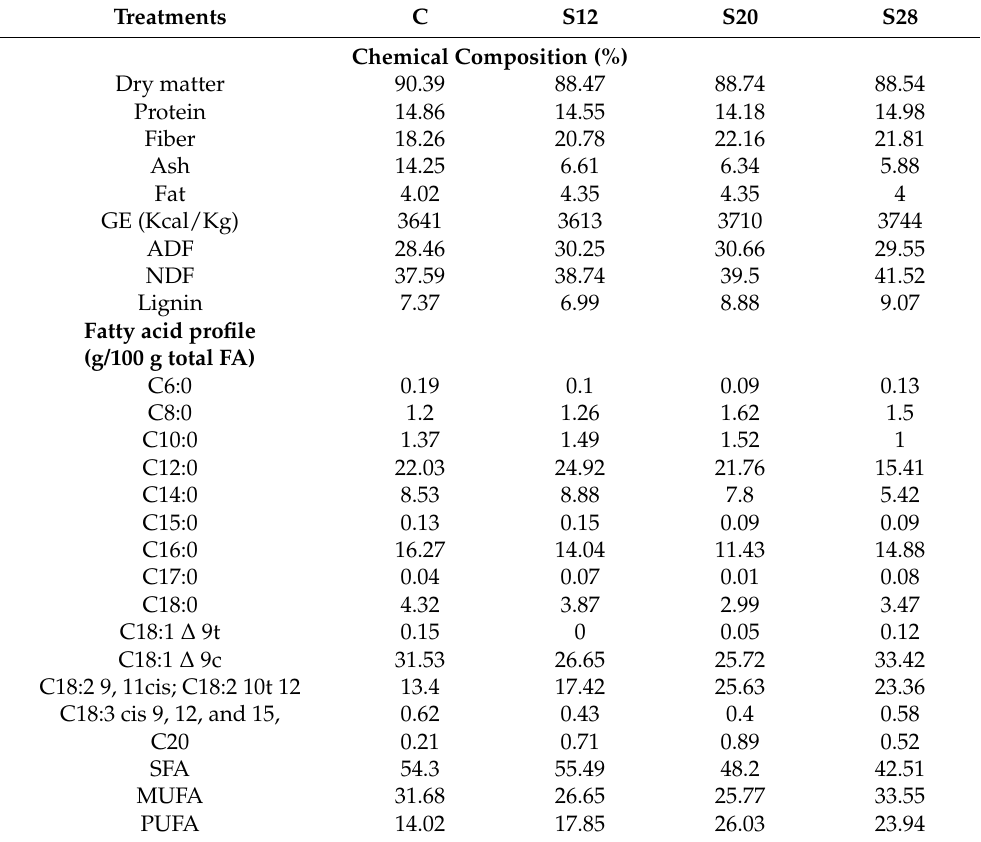
Table 1. Experimental diet composition and fatty acid (FA) profiles.